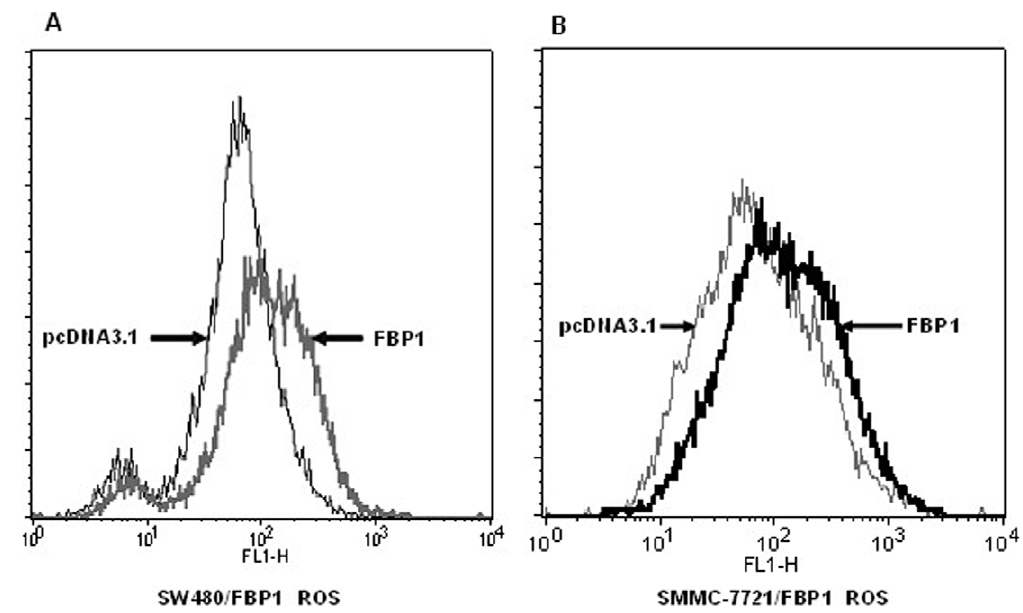
Figure 6. Exogenous FBP1 increased ROS levels in liver and colon cancer cells. The effect of ectopic FBP1 expression on oxidative stress was determined by flow cytometry assay as shown in ( A ) and ( B ). Stable cells were stained with DCFH-DA and then the redox state of cells was measured by flow cytometry.